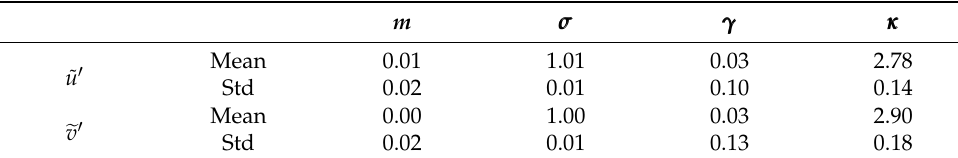
Table 2. Mean and standard deviation of the mean, standard deviation, skewness, and kurtosis of ũ (cid:48) and (cid:101) v (cid:48) .